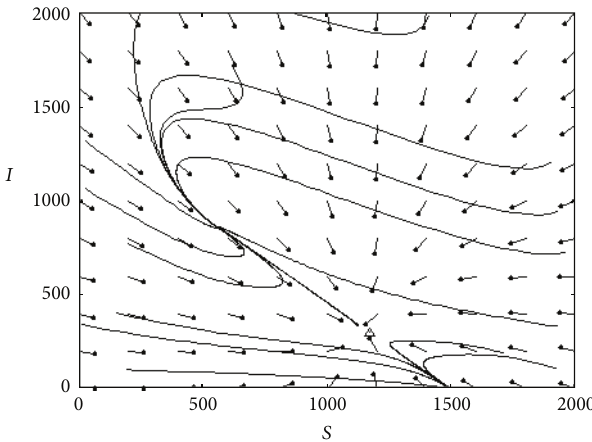
= 240 , 𝜆 = 0.00012 , 𝛼 = 1 1 = 0.0001 , 𝑏 = 550 , 𝜇 = 0.5 . 2 2 2